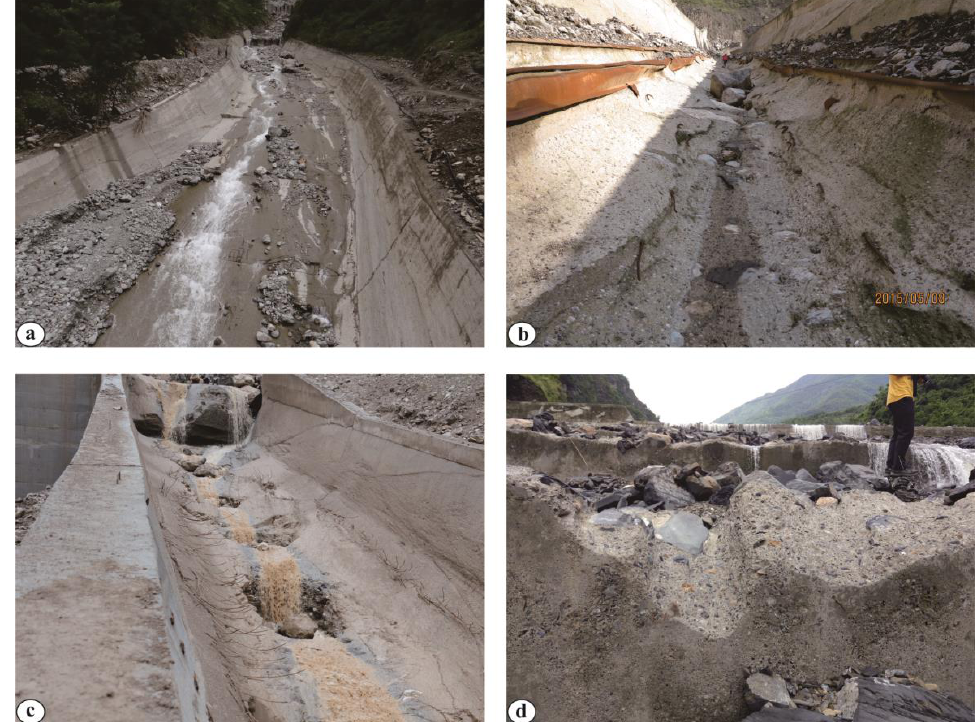
Figure 3. Typical abrasion morphology of mitigation works of debris flow. ( a ) uniform surface peeling (USP) in Yinxingping gully, Wenchuan county; ( b ) plowing groove (PG) in Haermu gully, Lixian county; ( c ) jumping erosion pits (JEP) in Xiaogangjian gully, Mianzhu county; ( d ) surface wear of the ground sills (SWGS) in Qinglinwan gully, Beichuan county.